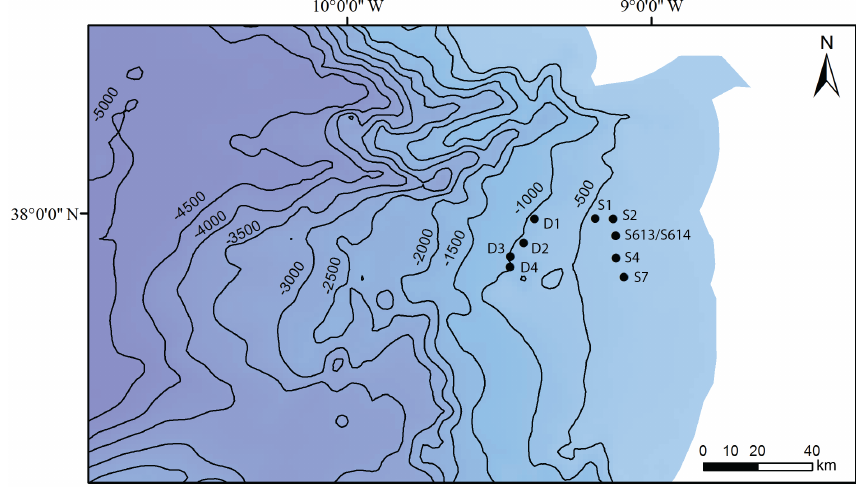
Figure 1. Location of the stations sampled during the RV Belgica cruises B2013/17 and B2014/15. Sampling stations are represented by black